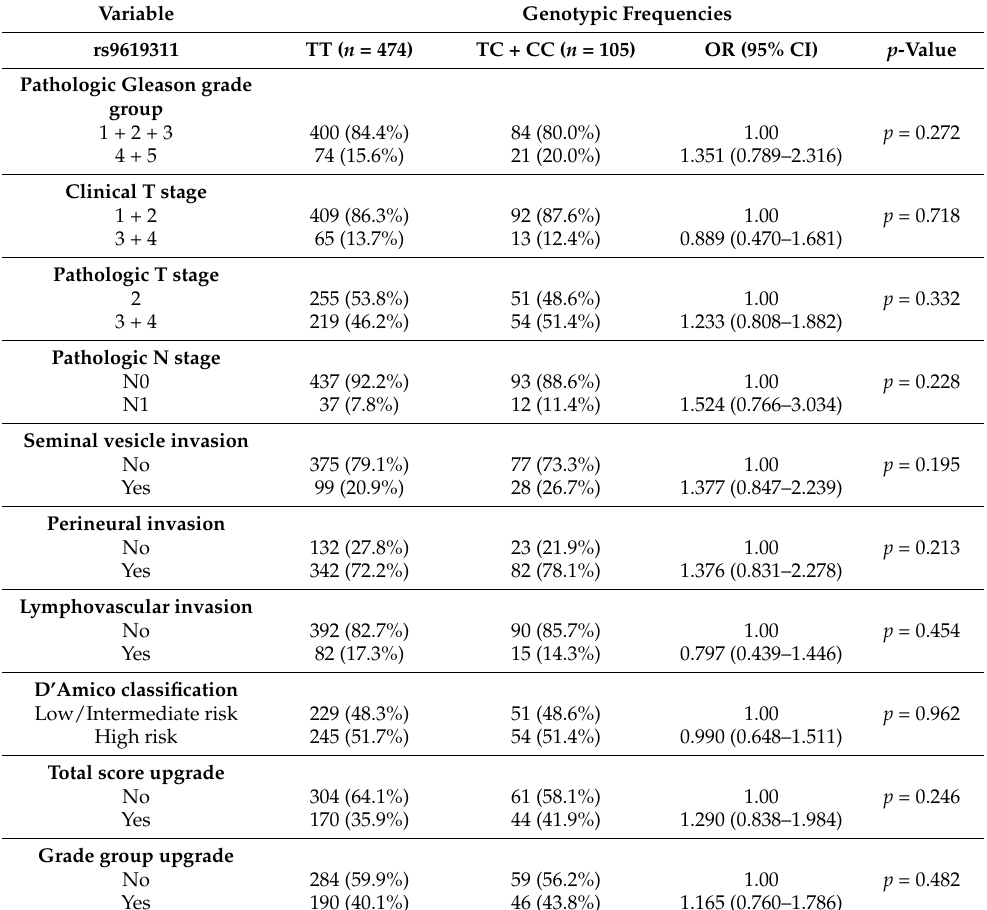
Table 4. Odds ratios (OR) and 95% confidence intervals (CI) of the clinical status and TIMP3 rs9619311 genotypic frequencies in 579 patients with prostate